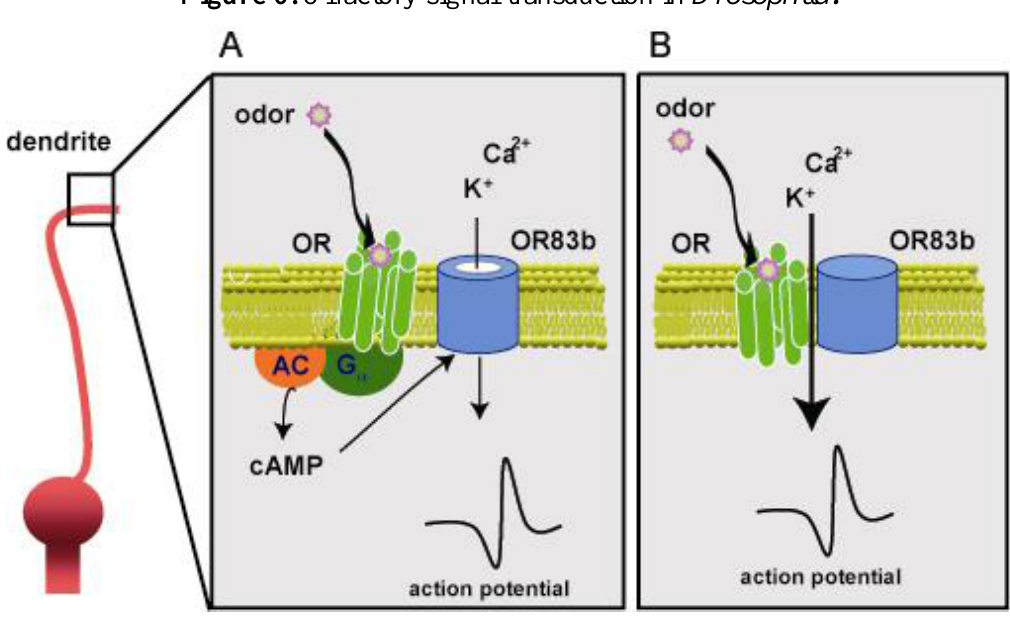
Figure 6. Olfactory signal transduction in